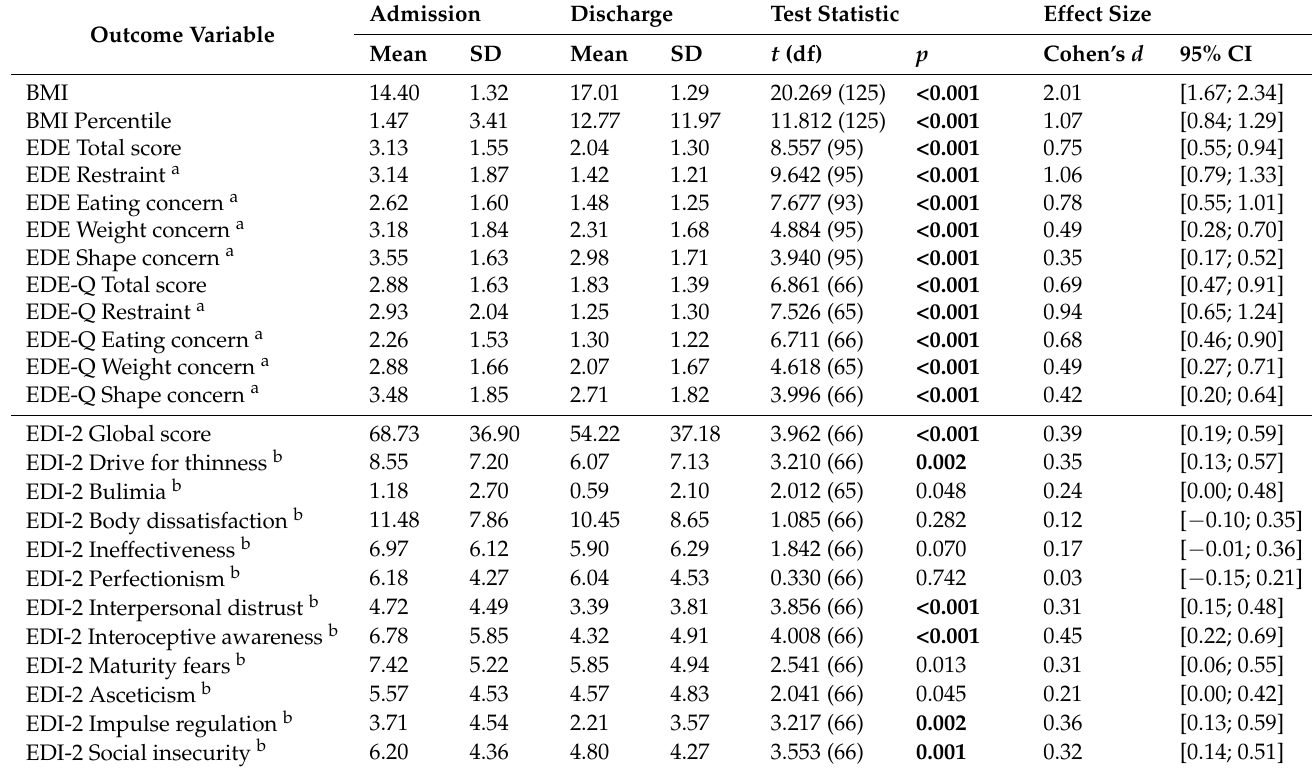
Table 2. Differences in BMI and eating disorder pathology between admission and discharge including effect